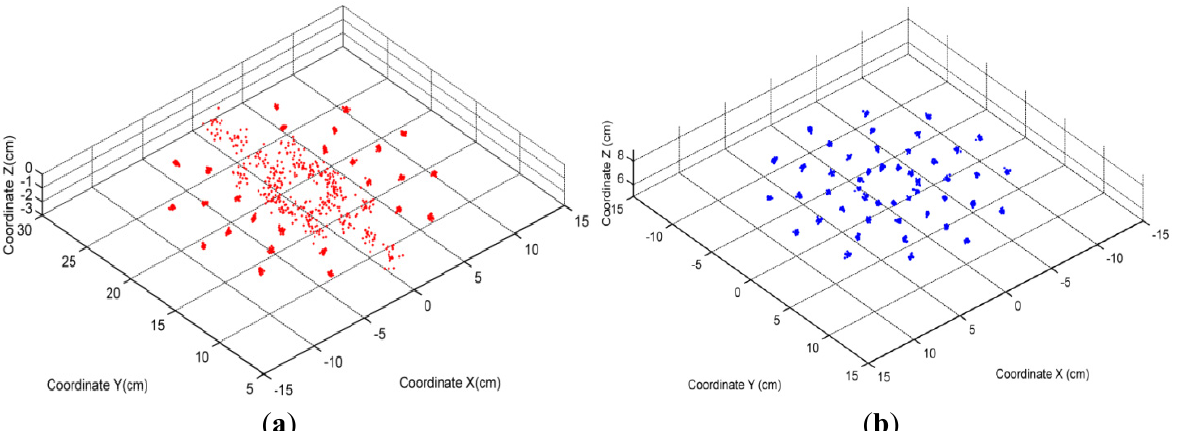
Figure 13. The results of the positioning experiment. ( a ) Results from the first layout style; ( b ) Results from the second layout